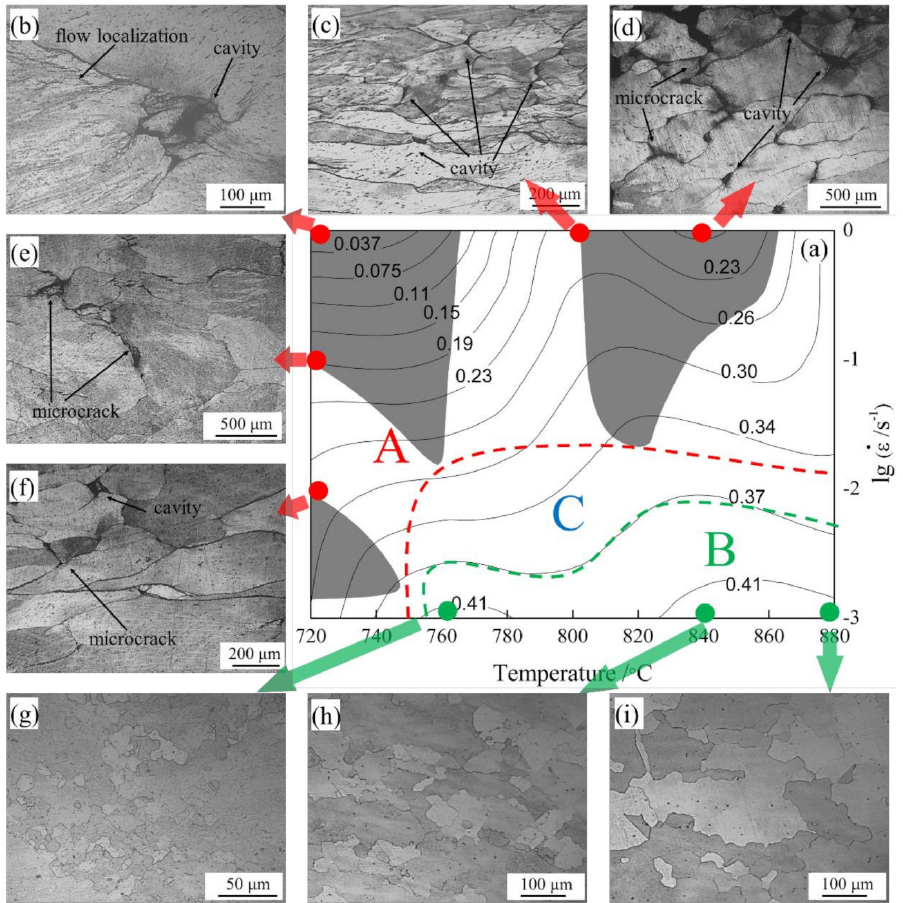
Figure 8. Hot working map of the samples deformed at a true strain of 0.9 and the corresponding representative microstruc- ture. ( a ) hot working map; ( b ) 720 ◦ C and 1 s − 1 , ( c ) 800 ◦ C and 1 s − 1 , ( d ) 840 ◦ C and 1 s − 1 , ( e ) 720 ◦ C and 0.1 s − 1 , ( f ) 720 ◦ C and 0.01 s − 1 , ( g ) 760 ◦ C and 0.001 s − 1 , ( h ) 840 ◦ C and 0.001 s − 1 , ( i ) 880 ◦ C and 0.001 s − 1